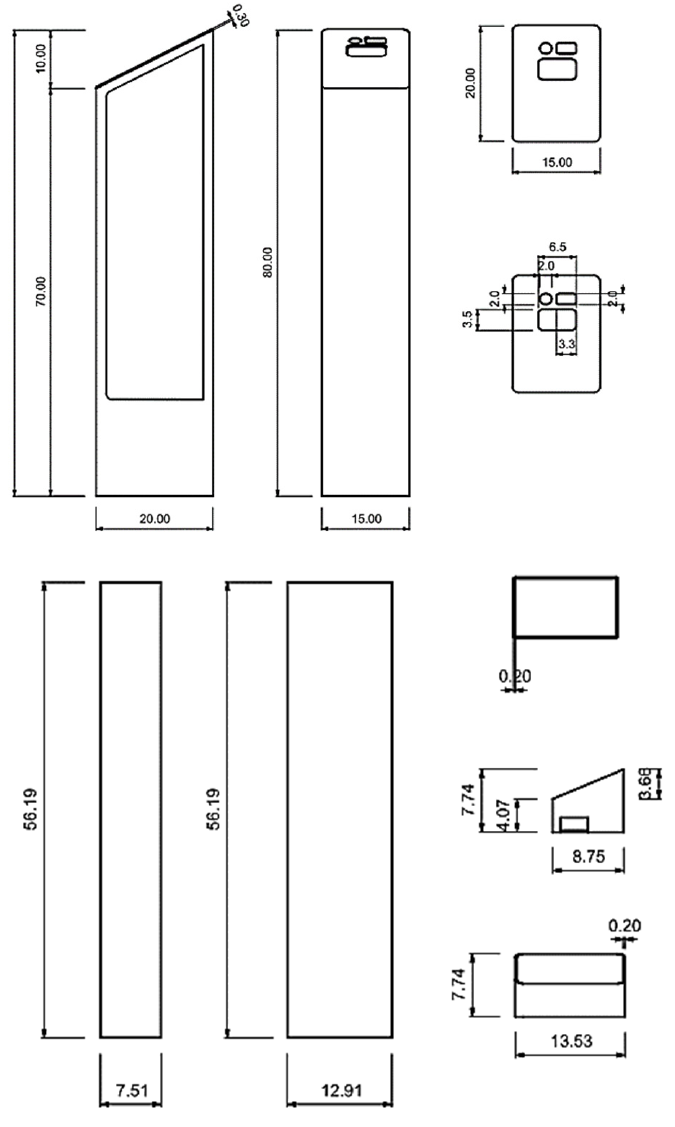
Figure 14. CAD 2D drawings.